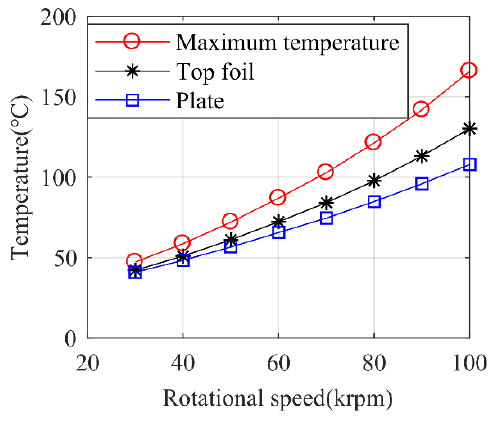
Figure 13. Relationship between bearing temperature and speed.